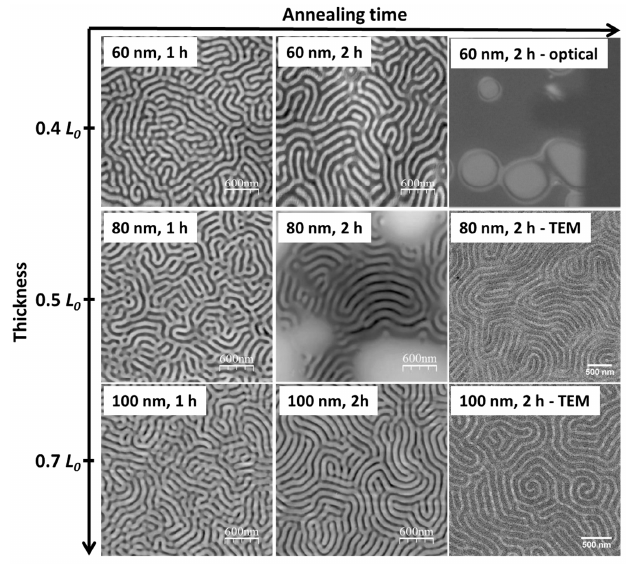
Figure 8. AFM surface height profiles, optical microscope image (upper-right corner), and TEM images of the PS- b -P2VP thin films annealed in chloroform vapor atmosphere at 27 °C for different time periods.